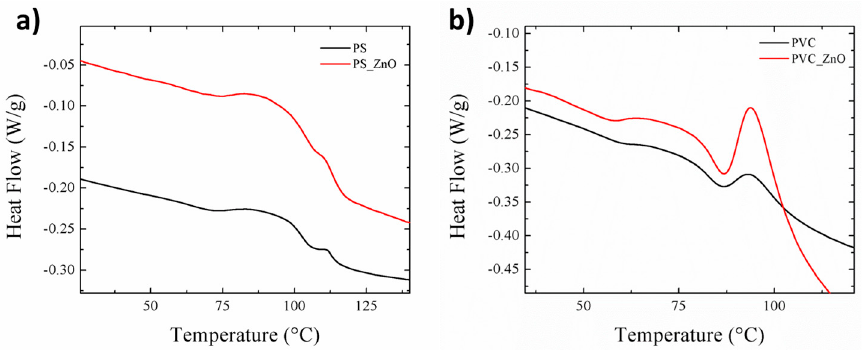
Figure 7. Comparative DSC curves for PS and PS_ZnO samples ( a ) and TGA curves for PVC and PVC_ZnO samples ( b ), respectively.